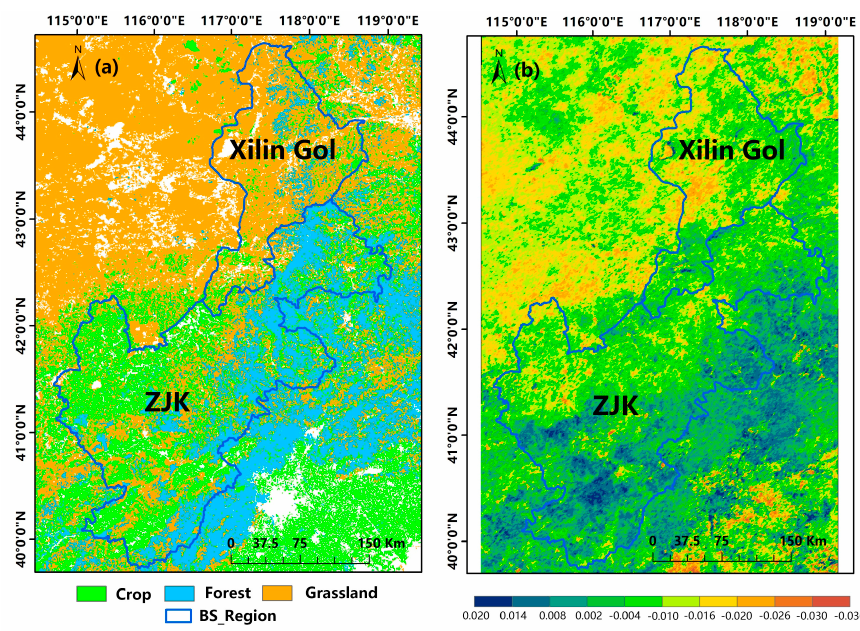
Figure 5. Land cover and Normalized Difference Vegetation Index (NDVI) trends in the study area. ( a ) land cover in 2015 and ( b ) NDVI trends from 2003 to